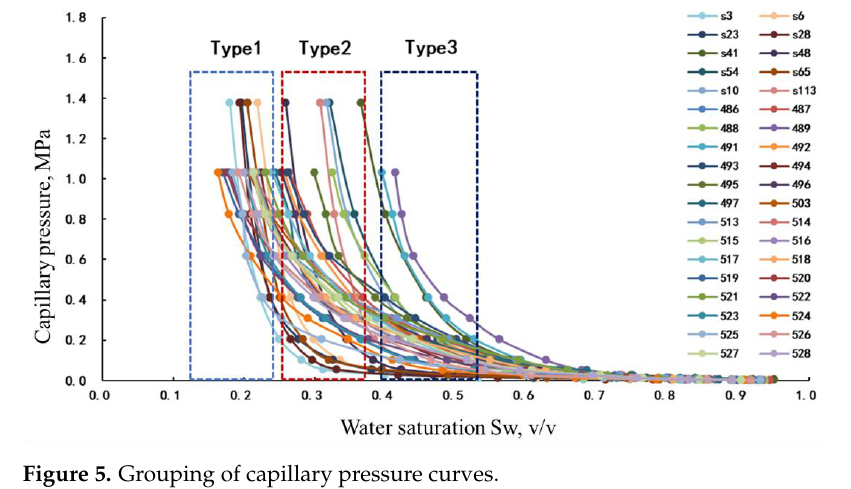
Figure 5. Grouping of capillary pressure curves.